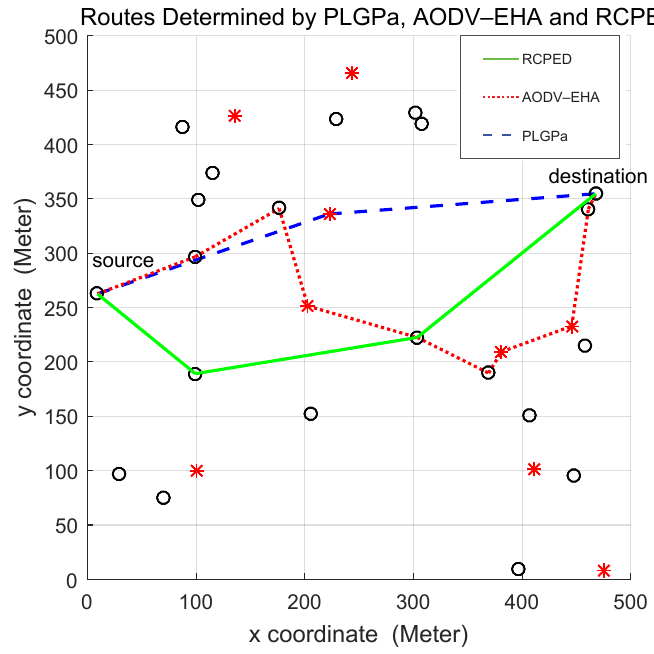
Figure 6. Route determination